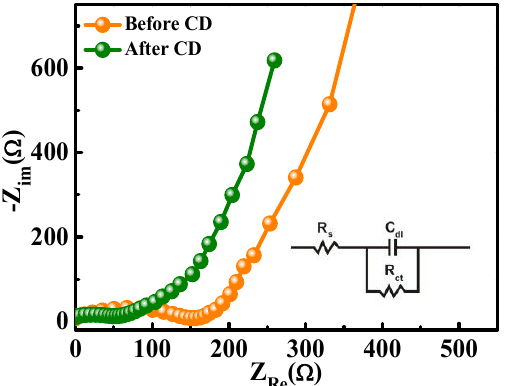
Figure 10. Nyquistplotforelectrochemicalimpedancespectroscopyfor β -SnWO 4 . Figure 10. Nyquist plot for electrochemical impedance spectroscopy for β-SnWO 4 . CD = charge- discharge.